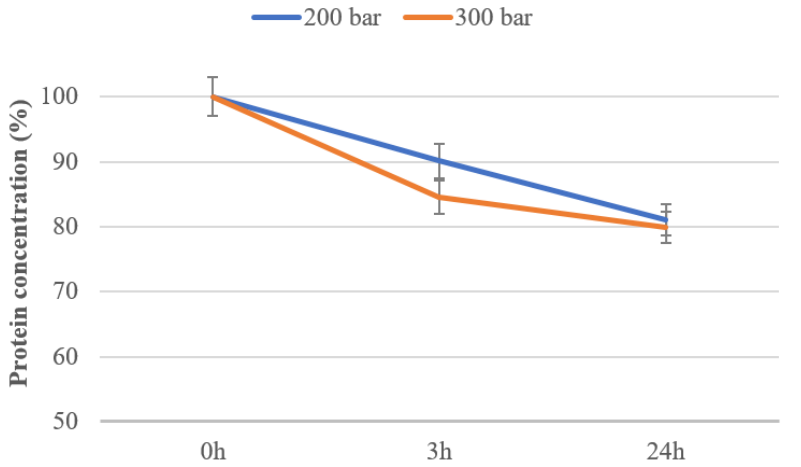
Figure 3. Comparison of the protein concentration of untreated (0 h) and scCO 2 -treated graham flour at 200 bar and 300 bar after treatment times of 3 and 24 h.